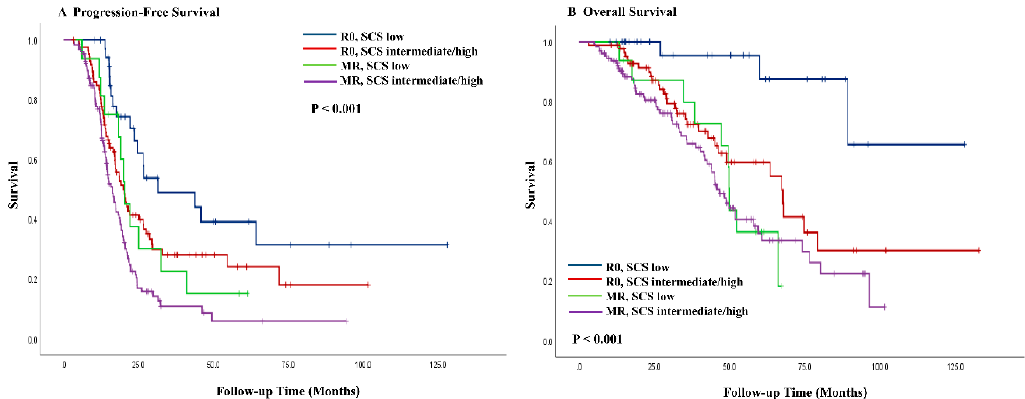
Figure 3. Kaplan–Meier curves of progression-free ( A ) survival and overall survival ( B ) stratified by residual disease and surgical complexity score. R0, no residual disease; MR, <1 cm of residual disease; SCS, surgical complexity score.